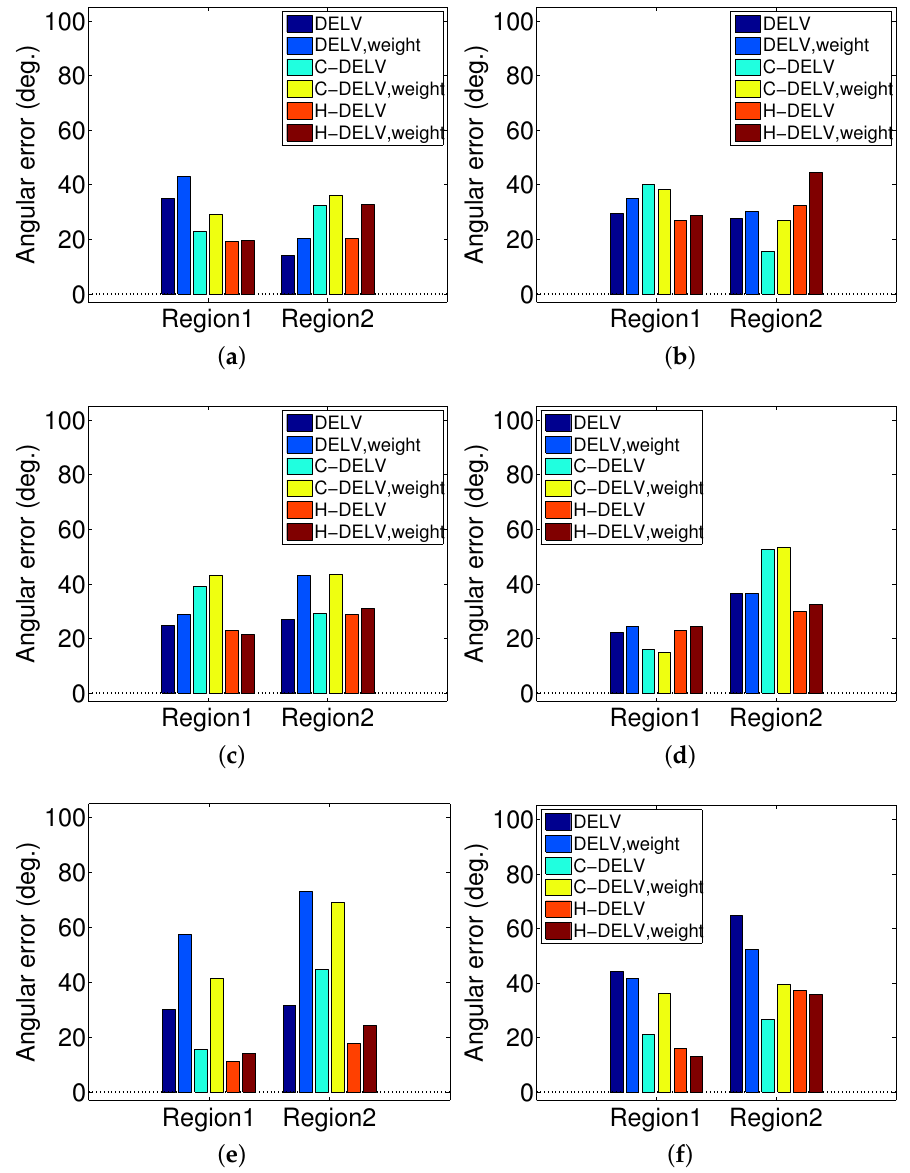
Figure 10. Angular errors for three different methods in Regions 1 and 2 (left column: with the reference compass, right column: without the reference compass); ( a , b ) env1; ( c , d ) env2; ( e , f )